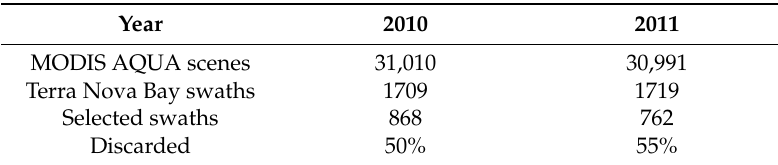
Table 1. MODIS scenes processed over the Terra Nova Bay during the 2010 and 2011 wintertime (April to